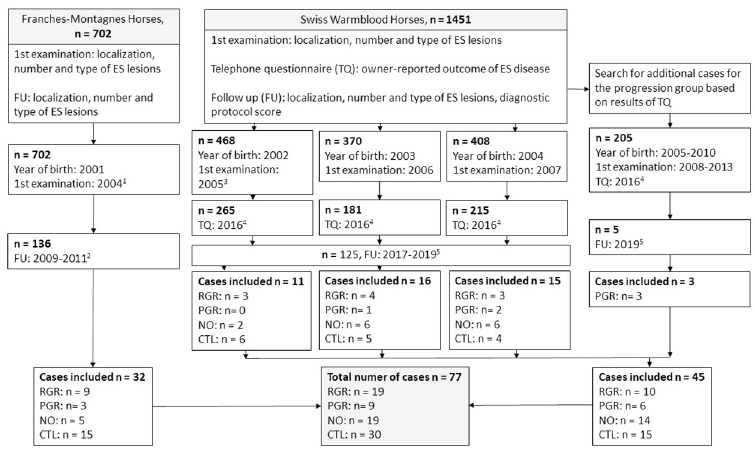
Fig 1. Process of recruiting study subjects. Abbreviations: TQ = telephone questionnaire, FU = follow-up examination, ES = equine sarcoid, RGR = regression, PGR = progression, NO = new occurrence, CTL = control, 1 = Mele et al., 2007, 2 = Berruex et al., 2016, 3 = Studer et al., 2007, 4 = Altermatt et al., 2021, 5 = Scho¨pfer, 2018.